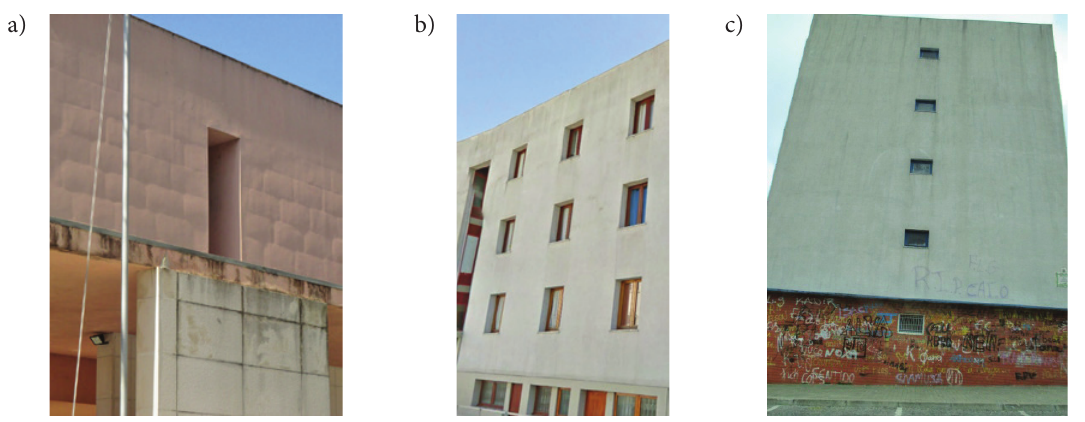
Figure 6. Case studies used to illustrate the application of the methodology